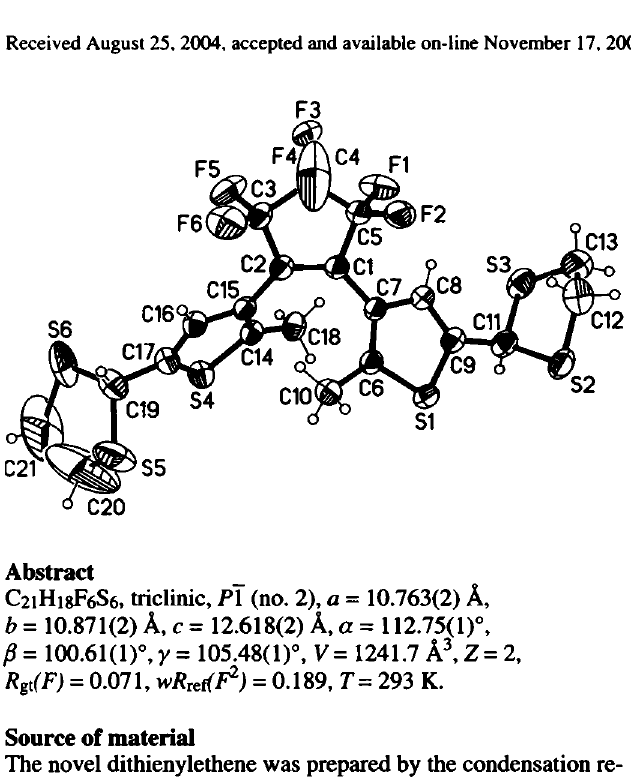
Table 1. Data collection and handling.